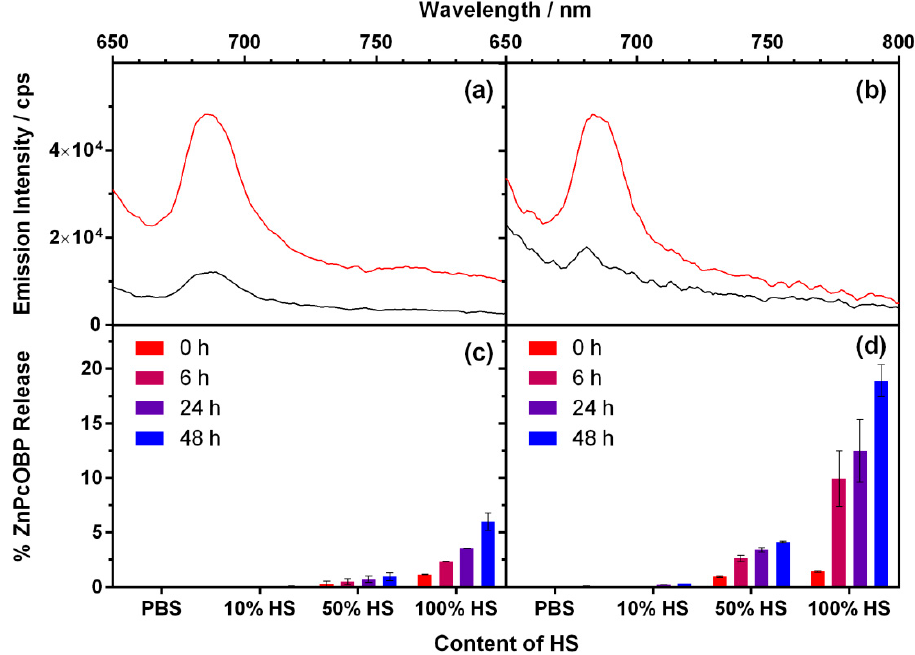
Figure 3. Fluorescence spectra of the supernatant after centrifugation of ( a ) MSNP4 and ( b ) MSNP5 nanoparticle suspensions incubated overnight in the presence (red) and absence (black) of BSA. Influence of human serum (HS) content on the release of ZnPcOBP from ( c ) MSNP4 and ( d ) MSNP5 nanoparticles as a function of the incubation time in PBS-HS mixtures.